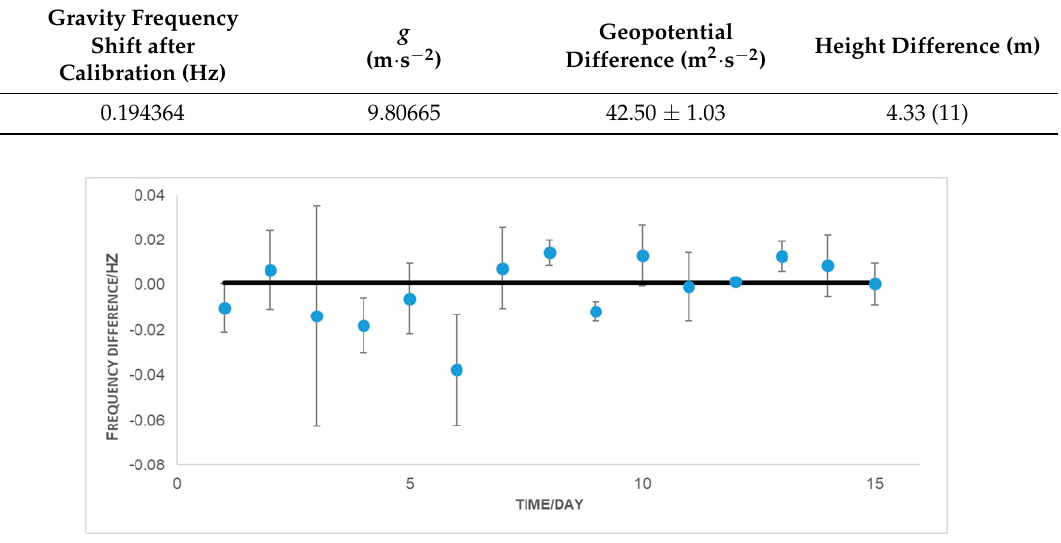
Figure 10. The mean of the frequency difference between two optical clocks located at the same site. Each blue point shows the frequency difference mean value between two optical clocks in one day, and gray vertical lines are the statistical uncertainty. The black horizontal line is the weighted